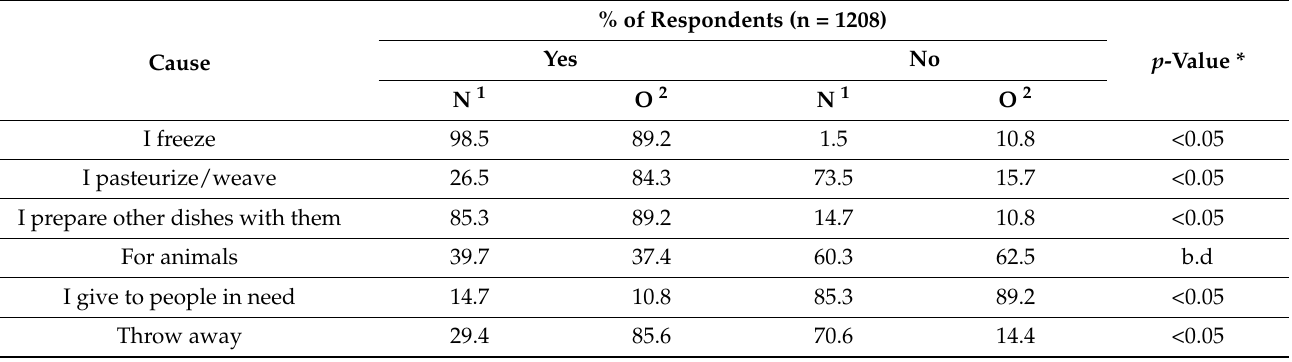
Table 6. Handling of the excess food by students.